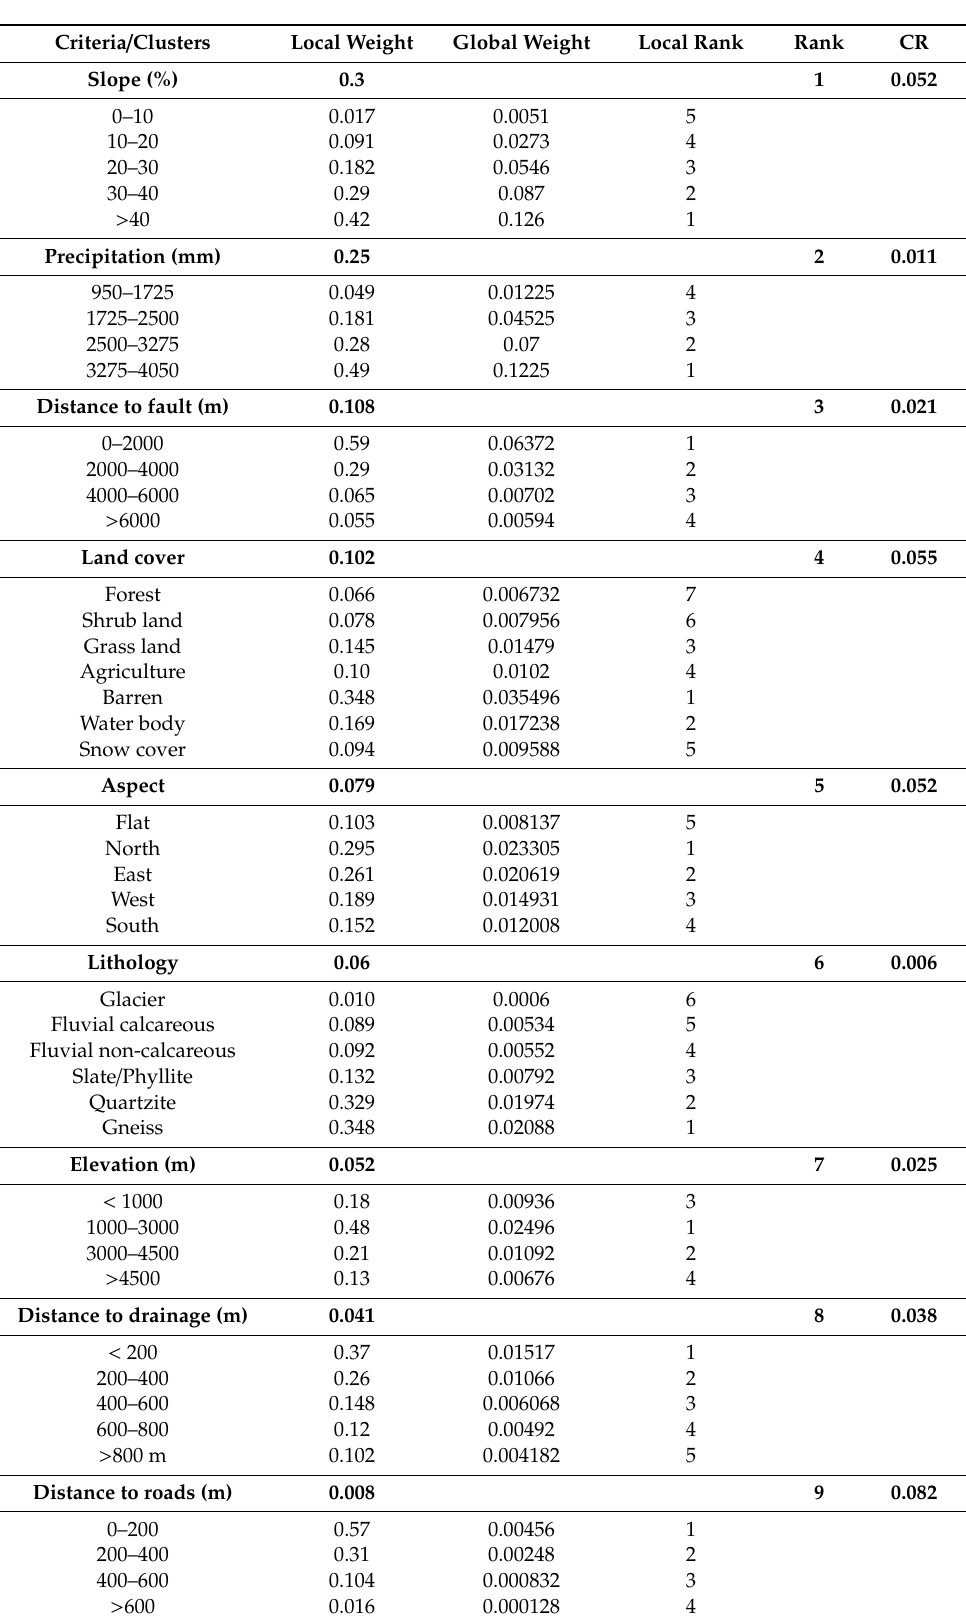
Table 6. FAHP model